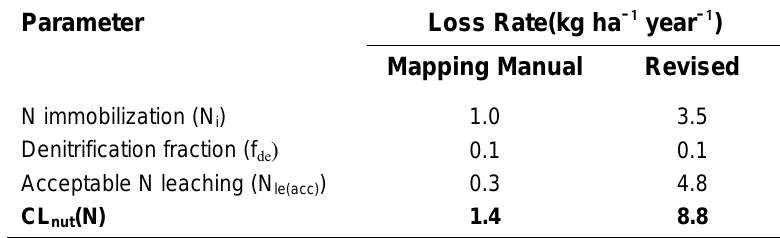
Calculation of Theoretical Critical Loads for Nutrient N with the SMB